Question: Write a single sentence explaining what this figure depicts.
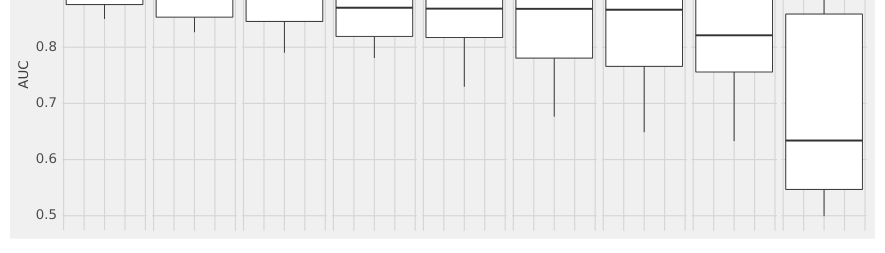
Answer: Distribution of the AUC for each method across the forecasting horizons.